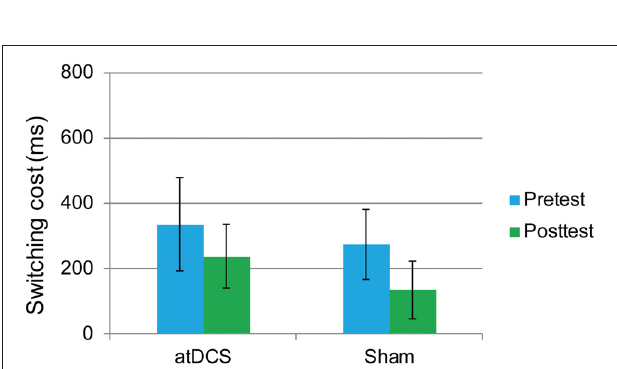
FIGURE 4 | The two-back performance at pretest and posttest for the anodal transcranial direct current stimulation and sham stimulation groups. The plots display the mean accuracy rate (A) and mean reaction time (RT; B ) in each group (anodal transcranial direct current stimulation and sham transcranial direct current stimulation) at pretest and posttest. Error bars represent standard errors of the mean. atDCS, anodal transcranial direct current stimulation.